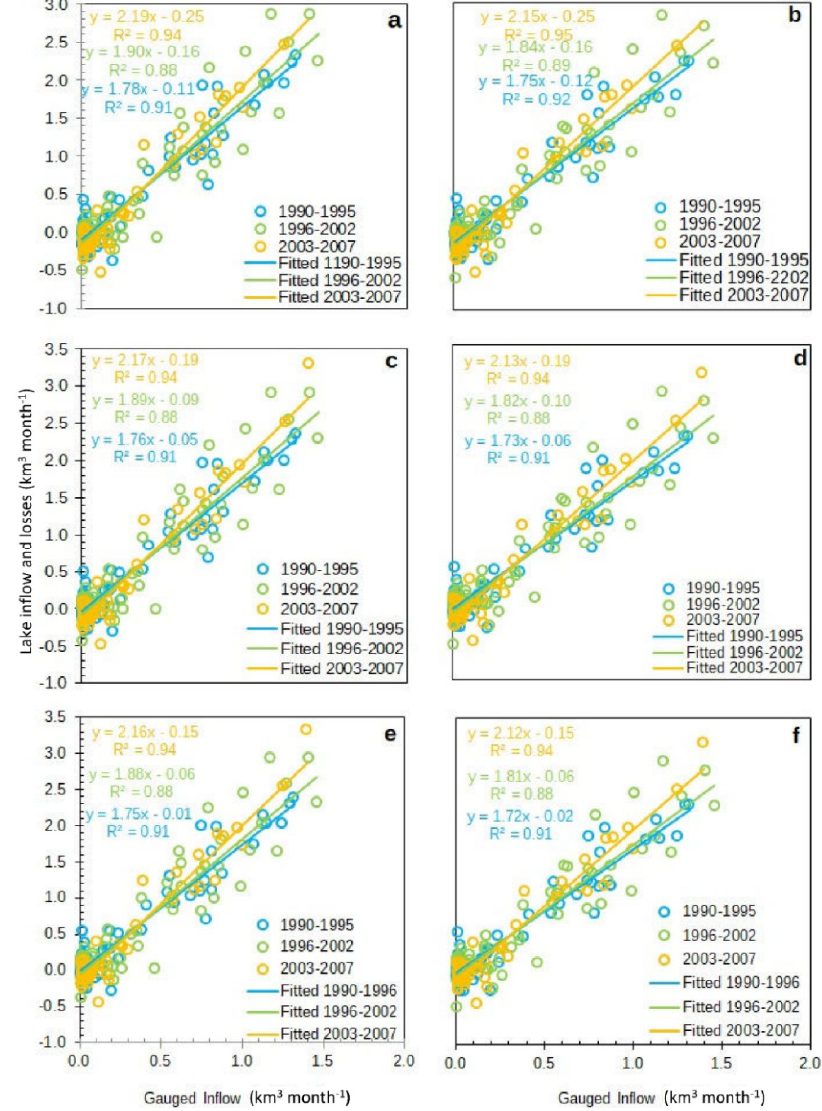
Figure 8. Regression of lake inflow and losses with the discharge of the four gauged watersheds ‐ Gilgel Abay, Gumara, Rib, and Megech for precipitation based on land‐based rain gauges ( a , c , e ) and lake + land‐based rain gauge ( b , d , f ) and lake evaporation rates of 1426 mm a −1 ( a , b ); 1650 mm a −1 ( c , d ) and 1789 mm a −1 ( e , f ).